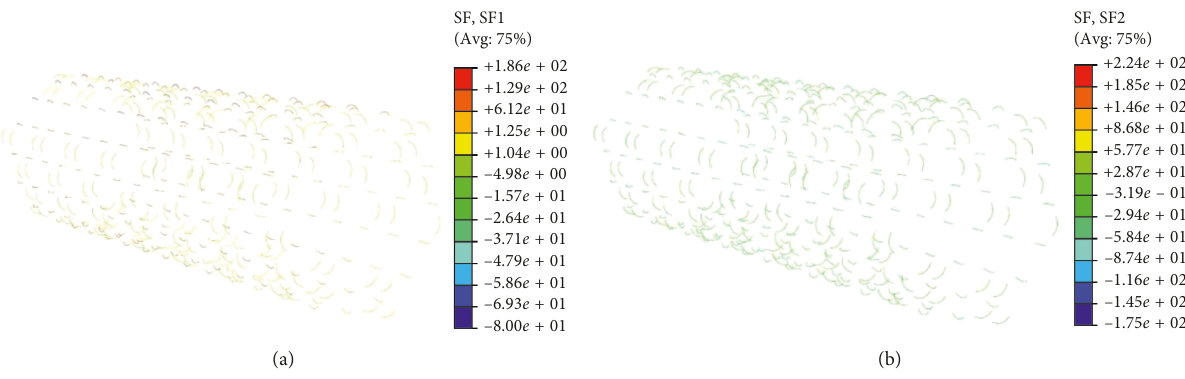
Figure 13: Internal force nephogram of bolts. (a) Bolt tension. (b) Bolt